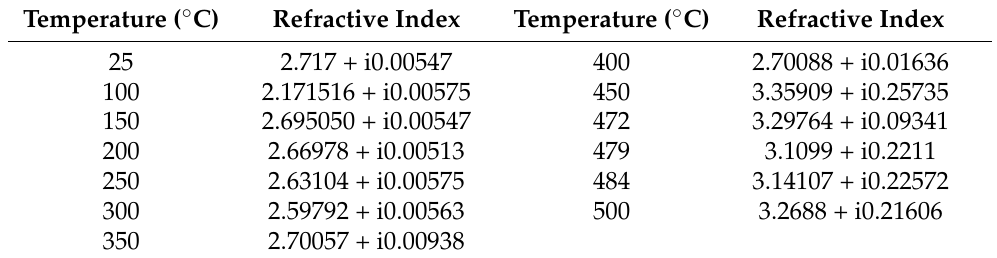
Table 2. Measured complex refractive index of Ge 40 Se 60 at different temperatures at 1550 nm